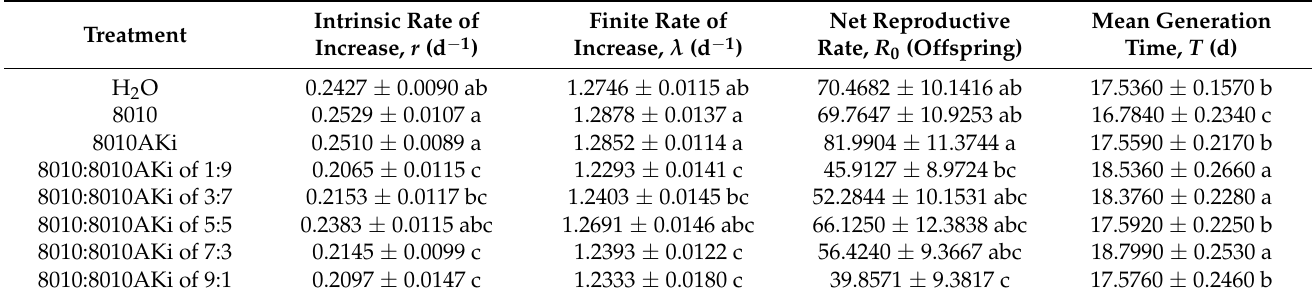
Table 1. Population dynamics parameters of P. xylostella in different treatments (Mean ±